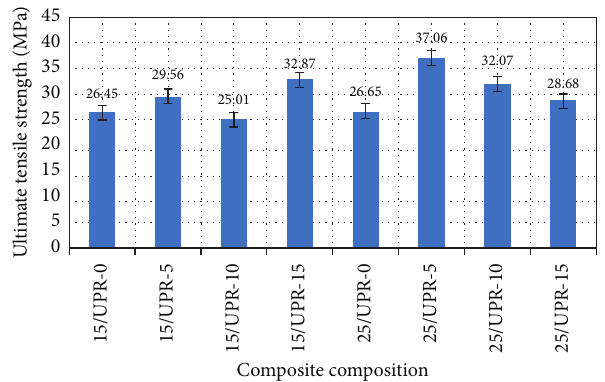
Figure 2: The variation of the ultimate tensile strength of the developed composite with changing the content of Al 2 O 3 filler and flax